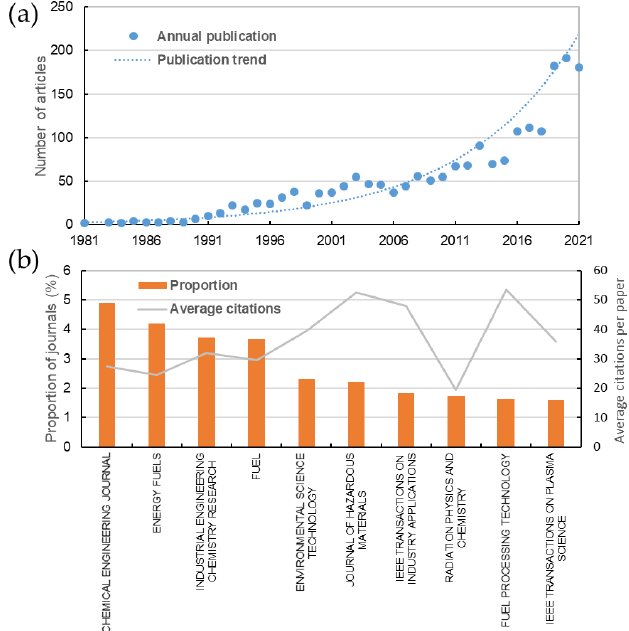
Figure 1. Publication of papers from the last four decades on NOx purification from flue gas. The data were retrieved from the Web of Science database with the topics of “NOx removal” or “DeNOx” and “flue gas” (totally 2078 papers). ( a ) represented the publication trend of papers between 1981 and 2021. ( b ) demonstrated the statistical results of top 10 journals ranked by the number of articles. Table 1. Post-combustion methods for NOx removal.